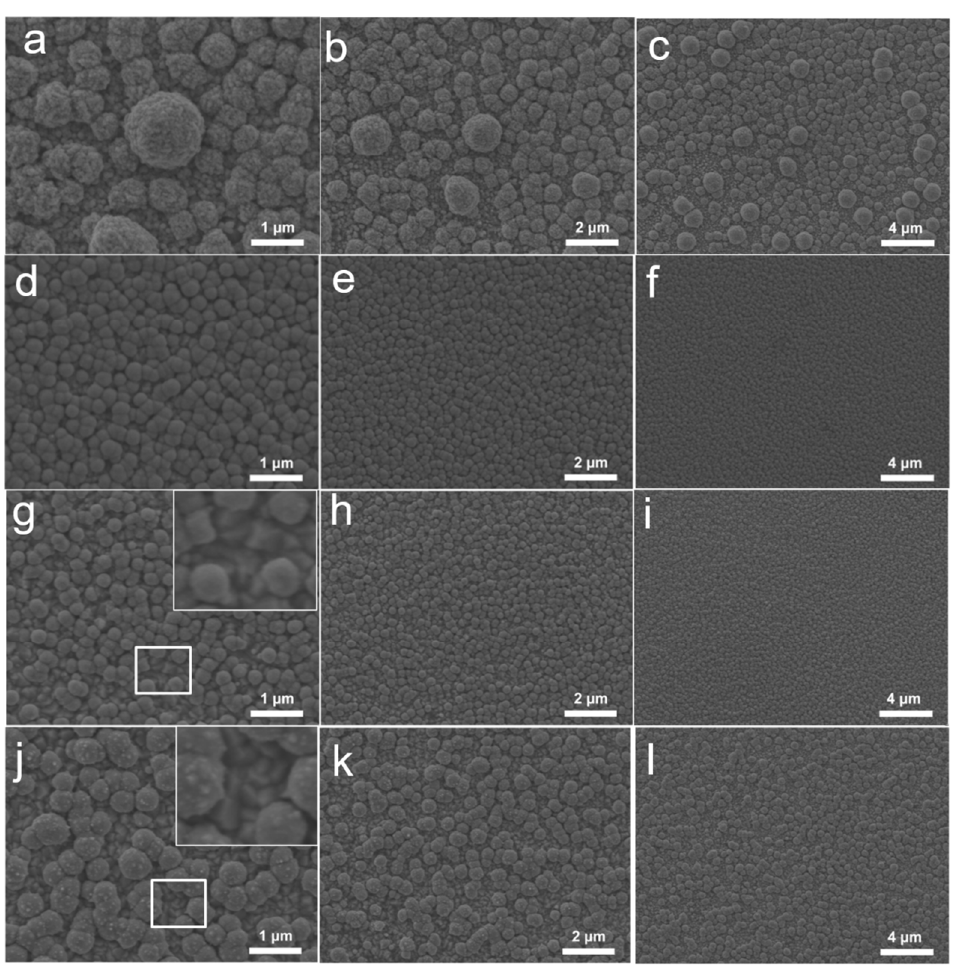
Figure 3. SEM images of the Cu-based electrodes with different scale bars for ( a – c ) Cu 0.3 , ( d – f ) Cu 0.6 , ( g – i ) Cu 0.9 , and ( j – l ) Cu 1.2 , inset images in ( g , j ) selected from the white squares, respectively.